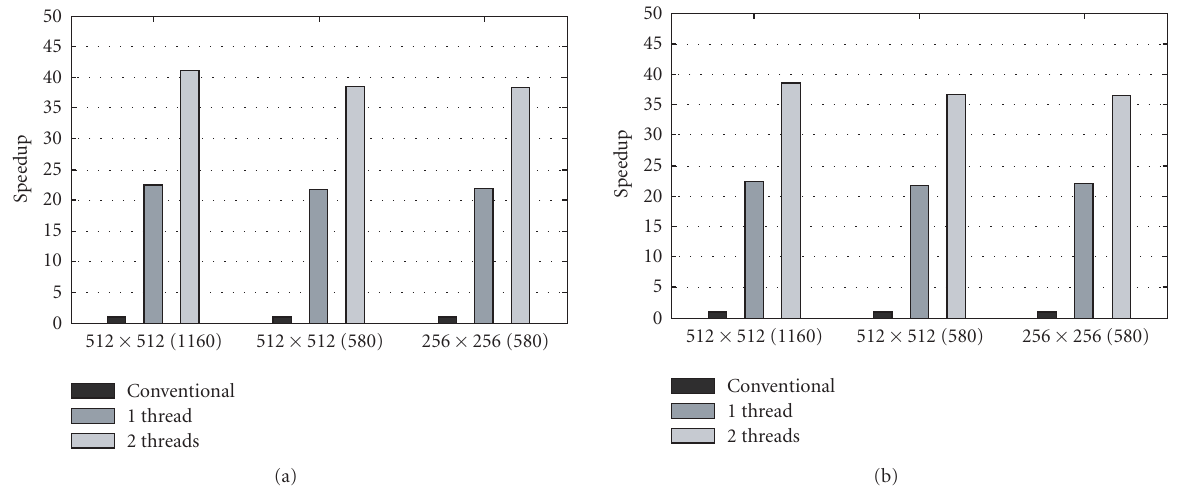
Figure 10: Experimental results on the speedup with our scheme: (a) results with the Pentium D PC and (b) with the Xeon PC.